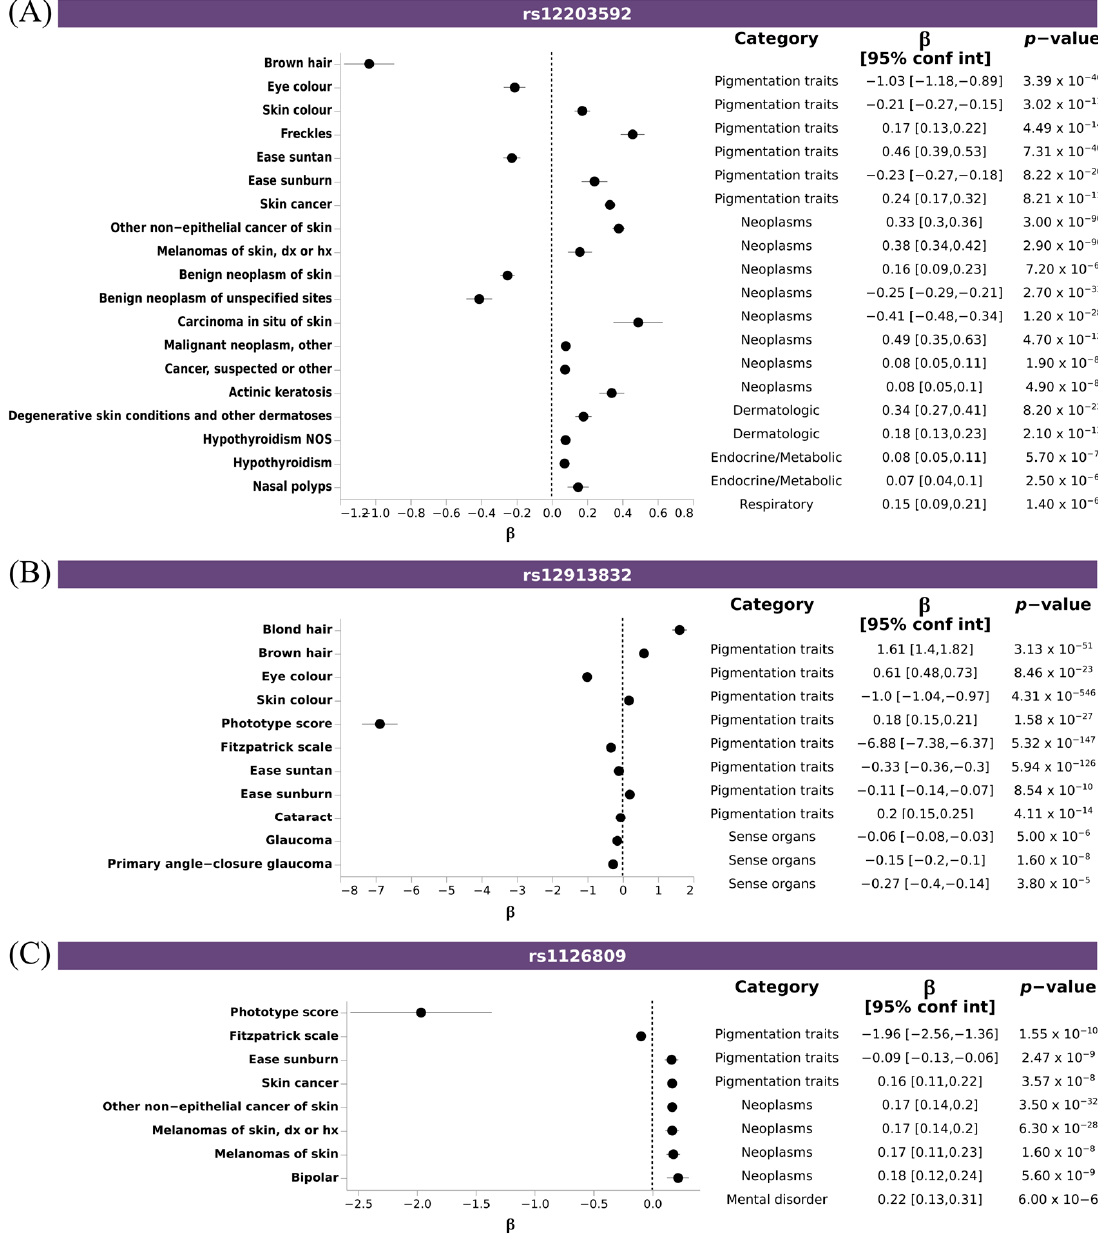
Figure 5. Pleiotropic SNPs associated with pigmentary traits and diseases. Forest plot depicting the effect size of disease-trait association of selected SNPS: ( A ) rs12203592 ( IRF4 ), ( B ) rs12913832 ( HERC2 ), and ( C ) rs1126809 ( TYR ). X axis indicated the effect size ( β ) for any trait reaching suggestive threshold (Y axis). Additional information about trait category, β , CI and p -value is shown.